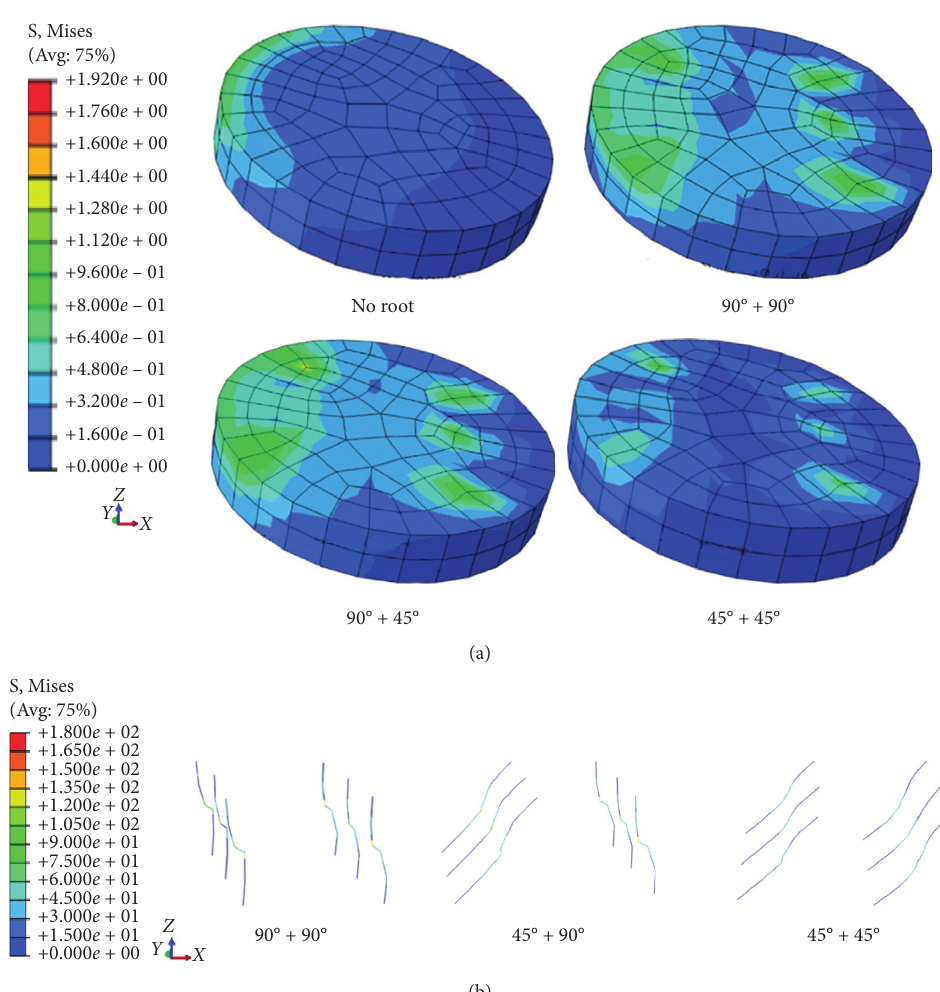
Figure 7: The stress cloud diagram of the composite and plant roots: (a) equivalent stress of bottom soil; (b) equivalent stress of plant roots.